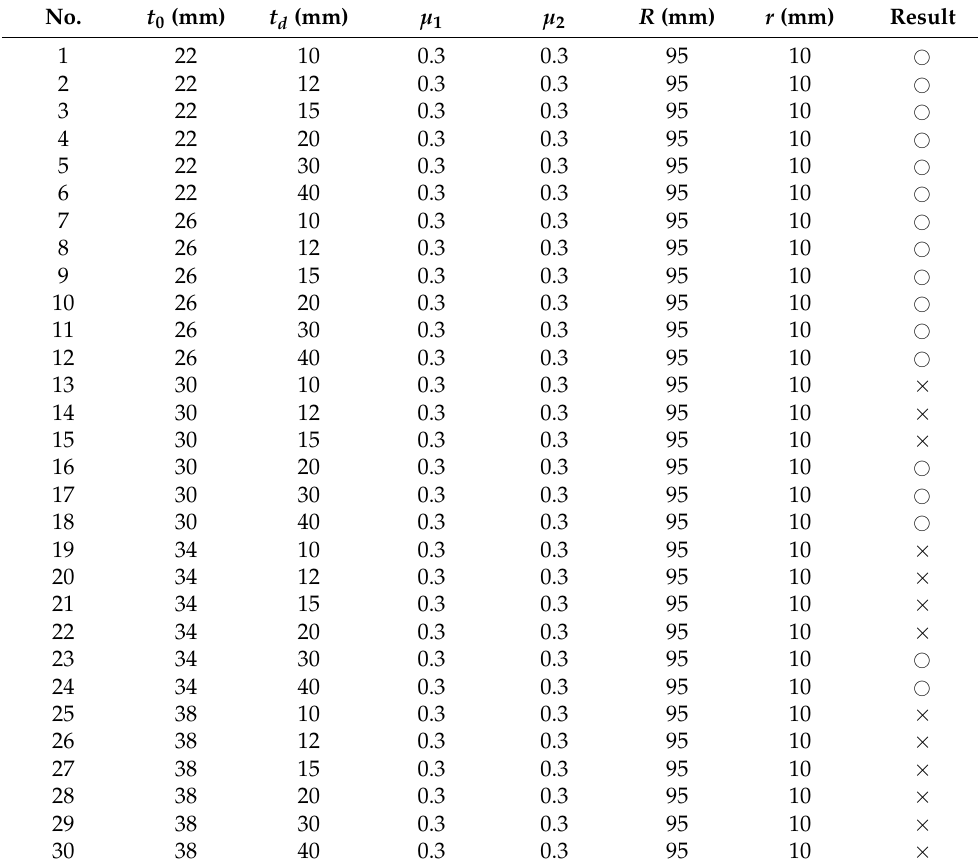
Table 2. Orthogonal simulation results of different wall thicknesses and bottom thicknesses of the